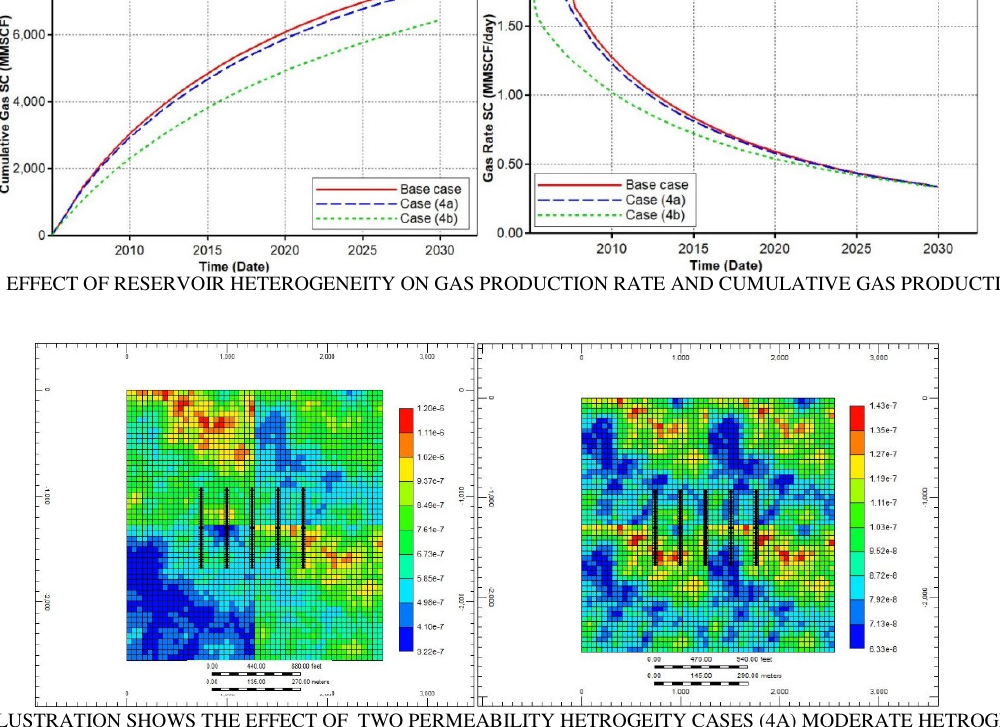
FIG. 9. ILLUSTRATION SHOWS THE EFFECT OF TWO PERMEABILITY HETROGEITY CASES (4A) MODERATE HETROGENITY CASE (4B)SEVERE